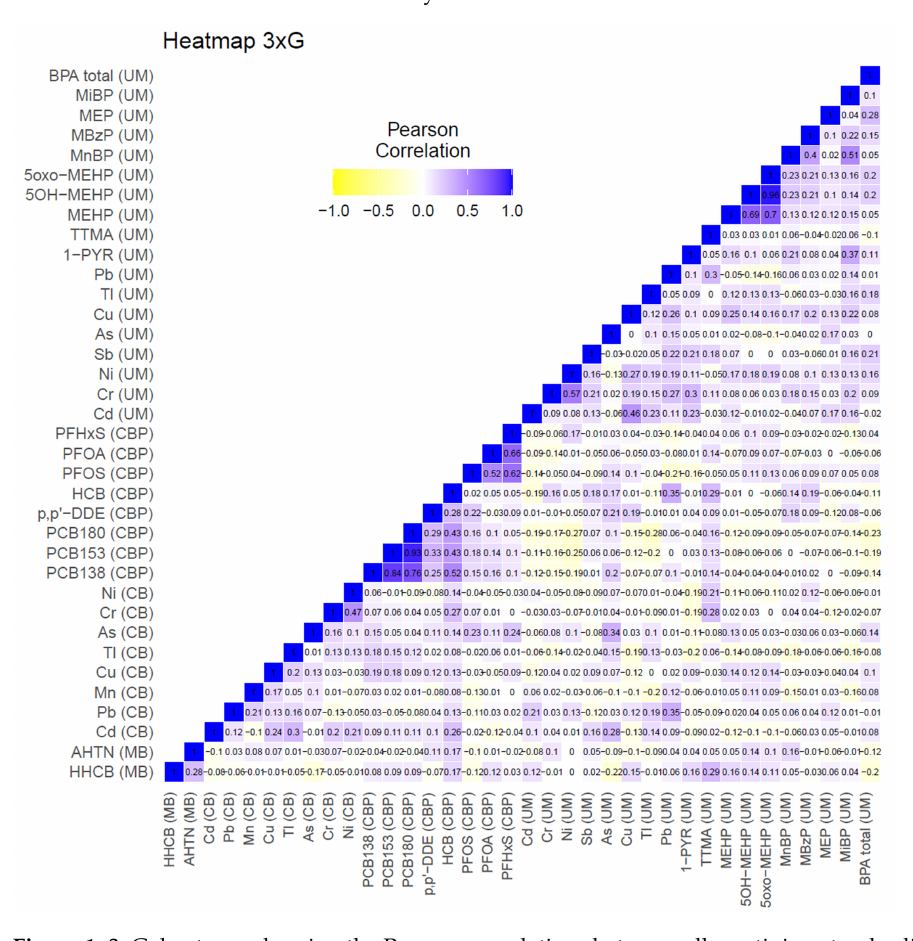
Figure 1. 3xG: heatmap showing the Pearson correlations between all creatinine-standardised and lipid-standardised measured biomarkers measured in urine and blood, respectively, available for the selected subset of participants. Data were corrected for age, BMI, and smoking status of the participants. The matrices in which biomarkers were measured are shown between brackets (MB: maternal blood, CB: cord blood, CBP: cord blood plasma, UM: morning urine).